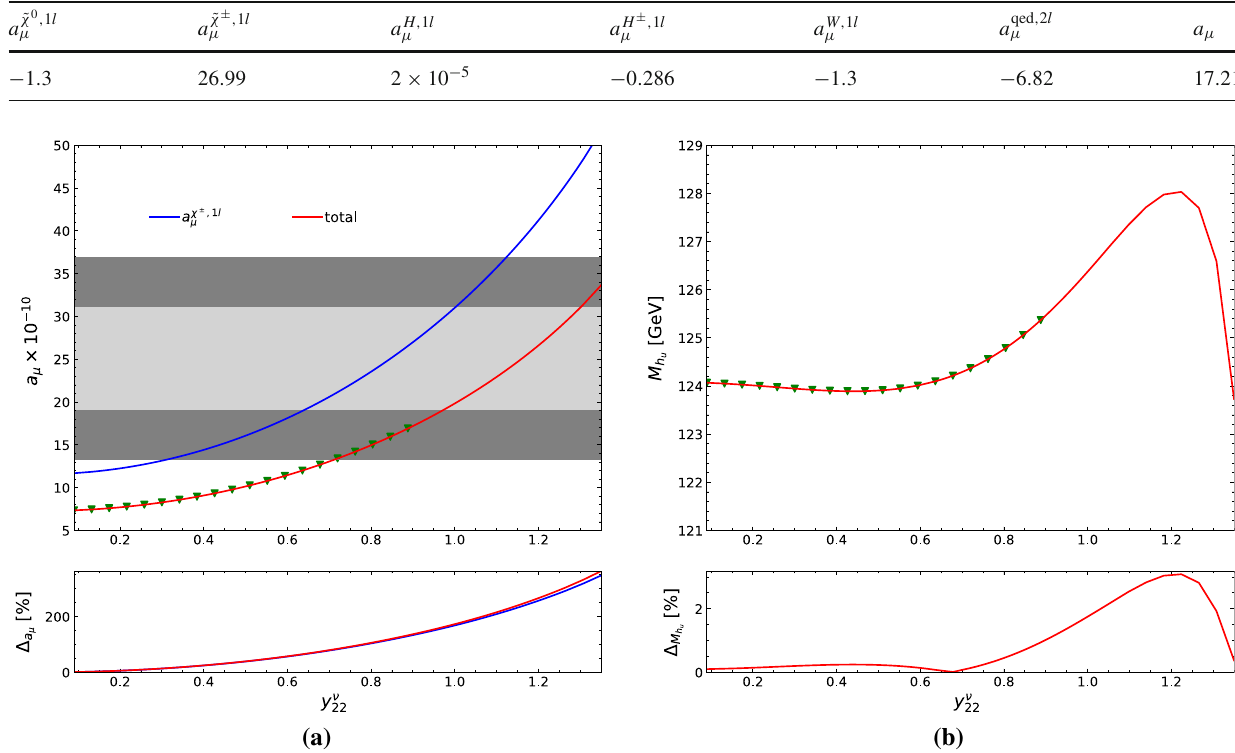
Table 4 The individual one-loop and two-loop QED contributions to the AMM of the muon in the NMSSM-nuSS. The sum of all contributions is presented in the last column. All values are normalized to 10 − 10